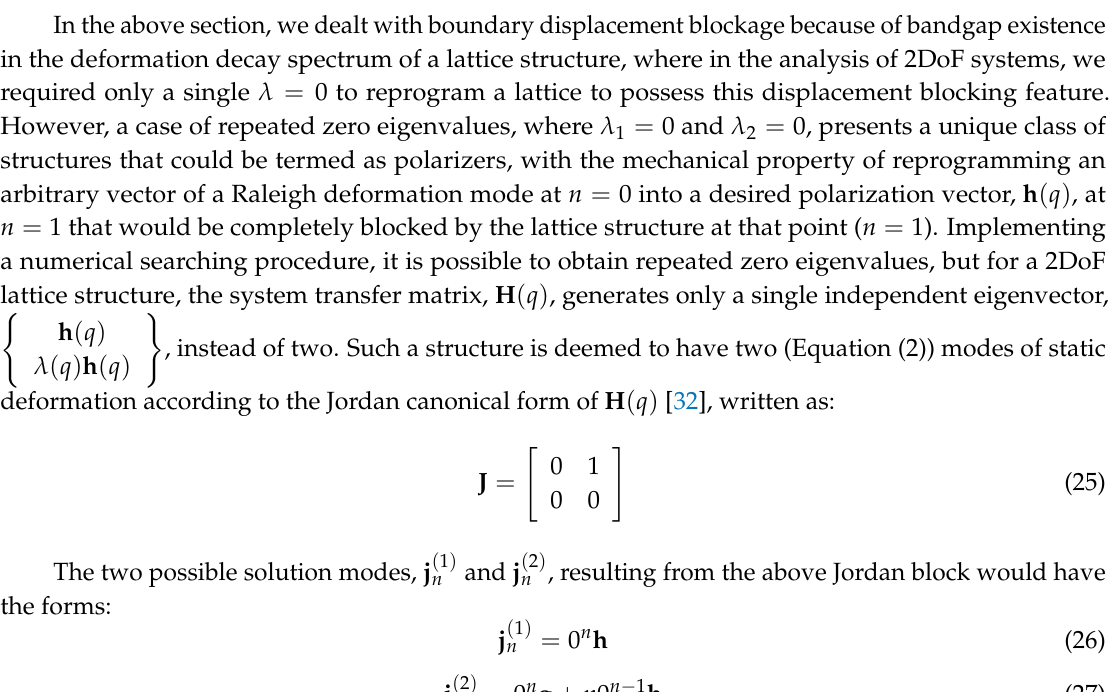
Figure 3. A phase diagram of the lattice material of Figure